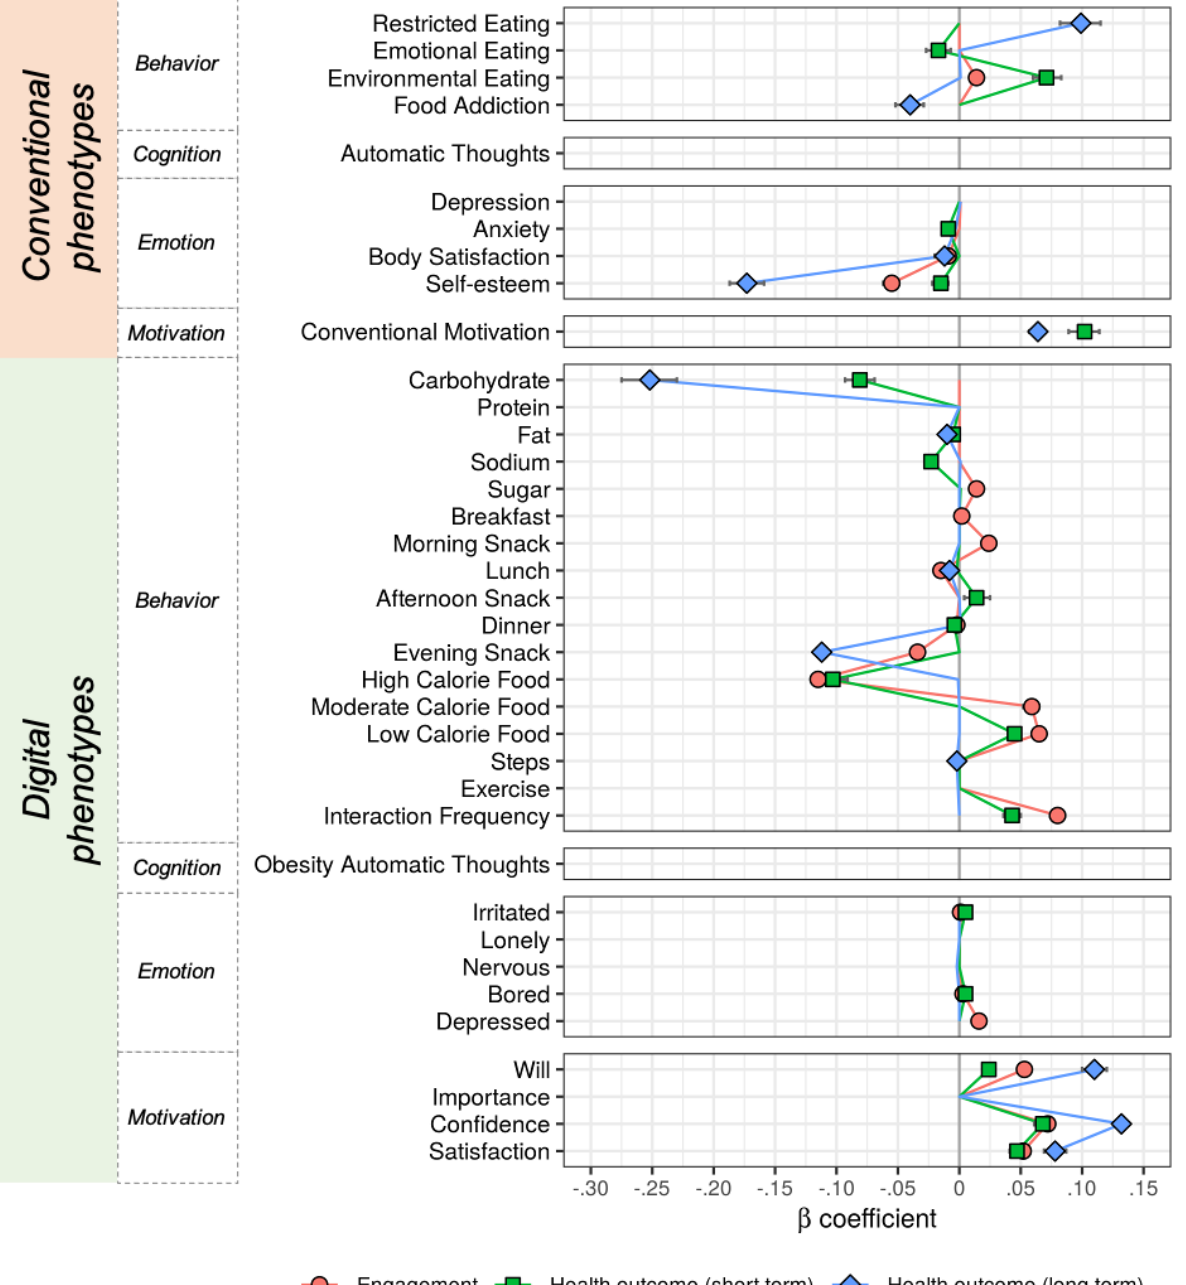
Figure 3. Multivariate patterns of conventional and digital phenotypes for predicting engagement (red) as well as short-term (green) and long-term (blue) health outcomes. Points indicate the averaged β coefficients across 100 repetitions of net elastic analysis (see the Methods section for details). A positive β estimate of a phenotype indicates an association between the phenotype and higher in-app activities (engagement) or more weight loss (health outcomes). The points, which contain zero in the simulated 95% ranges, are